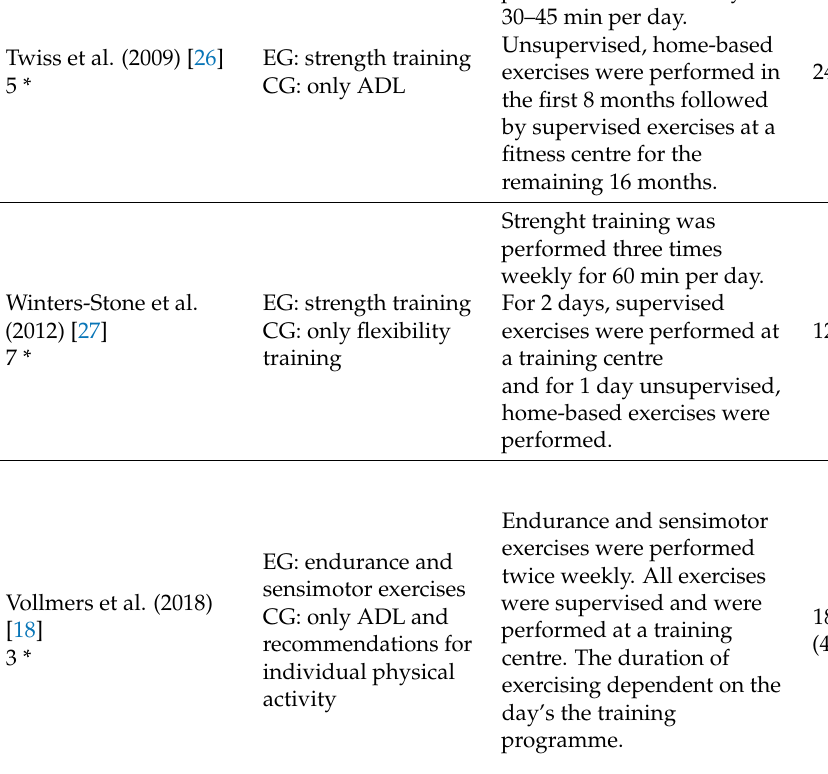
Measurement Time Measures Results